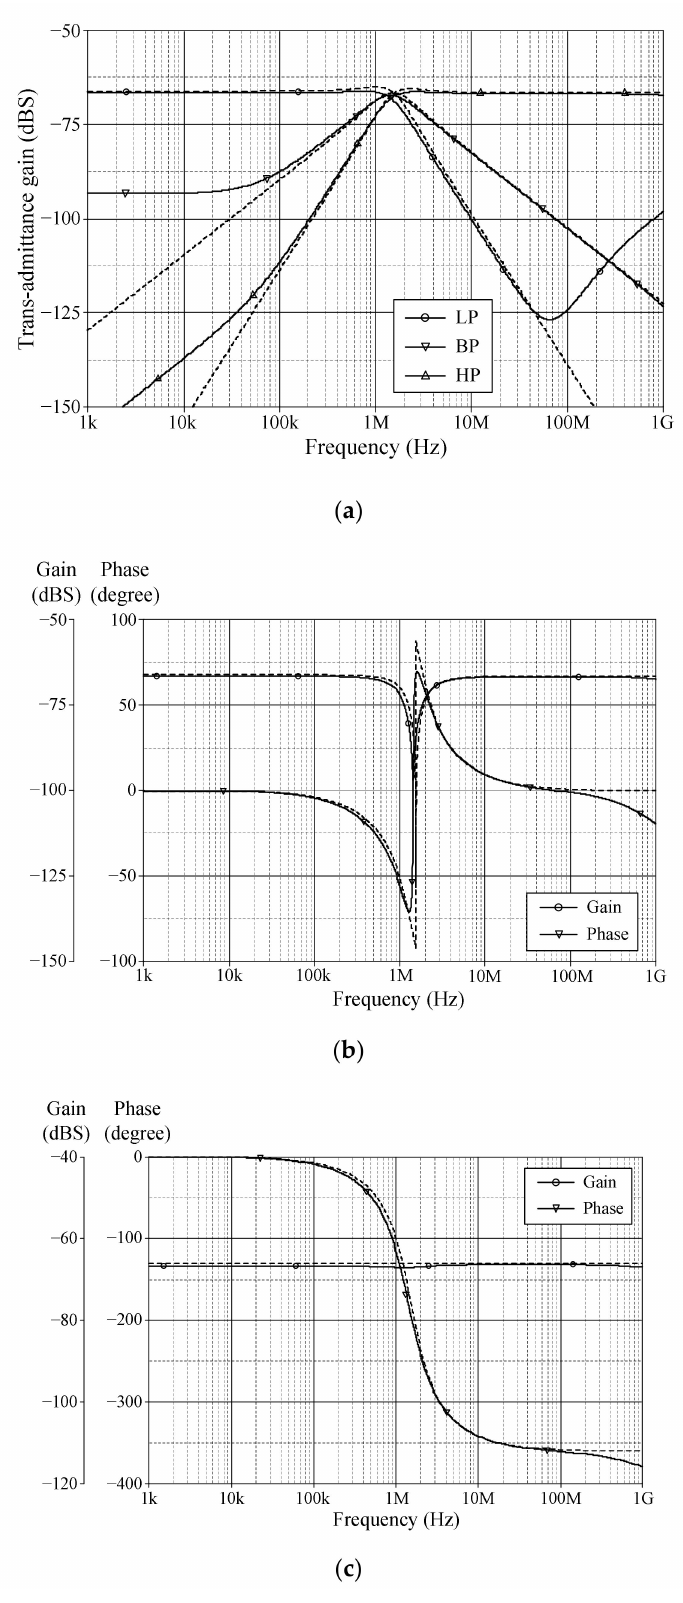
Figure 6. Ideal (dashed line) and simulated (solid line) frequency responses for TAM: ( a ) LP, BP and HP; ( b ) BS; ( c )